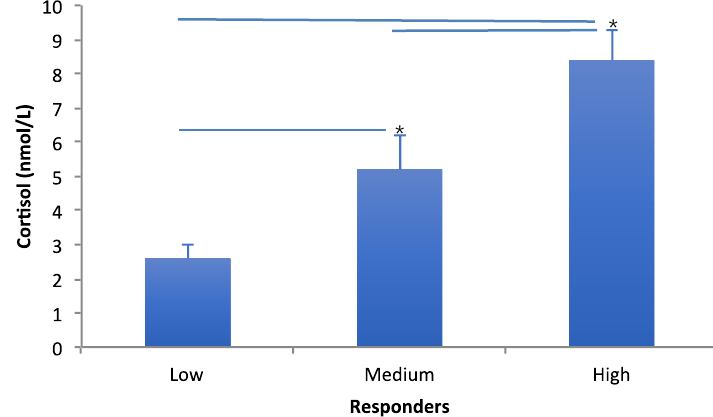
Figure 1. Mean cortisol ( ± SD) levels for ‘low’, ‘medium’ and ‘high’ responders. Asterisks (*) and lines